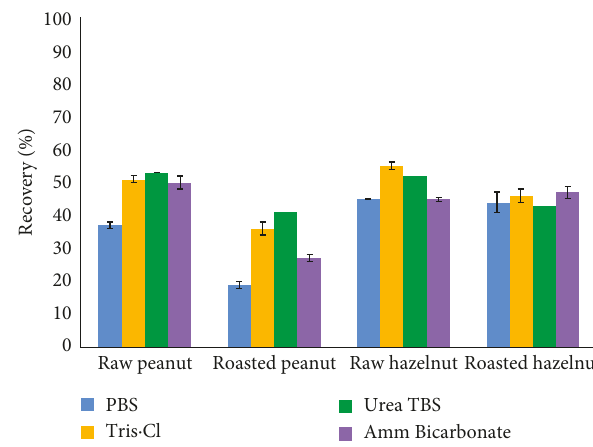
Figure 1: Comparison of extraction yields for raw and roasted peanut and hazelnut samples provided by different buffer com- positions: PBS (10mM phosphate buffer saline pH